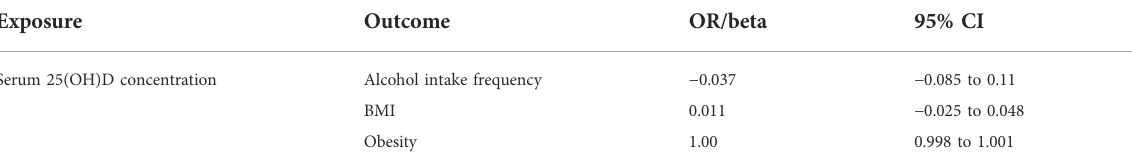
TABLE 3 The IVW estimates of the primary and replicated instrument variables on the LBP potential risk factors.